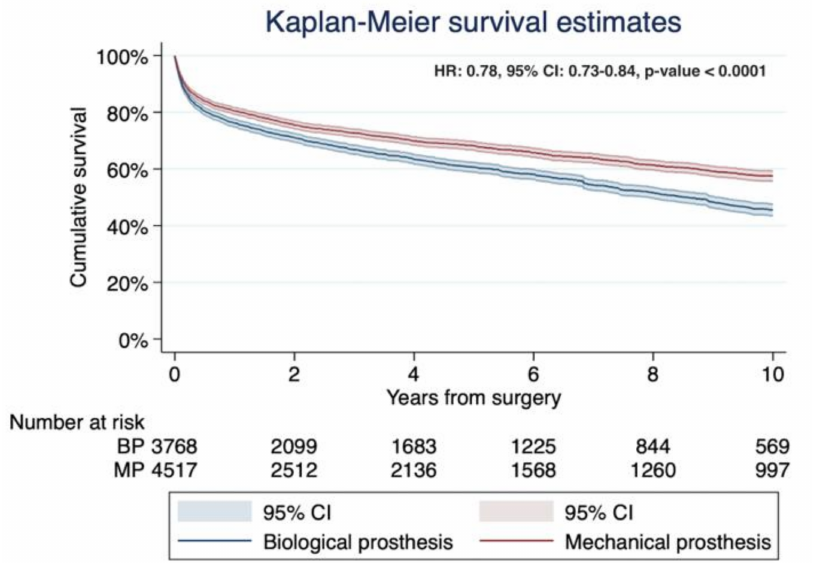
Figure 4. Kaplan–Meier survival curves of the pooled sample. The MP group was associated with bet- ter long-term survival compared to the BP group. All databases were merged into one global database. The log-rank test was statistically significant, favoring the MP group ( p < 0.0001). Abbreviations: HR, hazard ratio; CI, confidence interval; MP, mechanical prosthesis; and BP, biological prosthesis. A smoothed hazard function according to the type of treatment is shown in Figure 5.